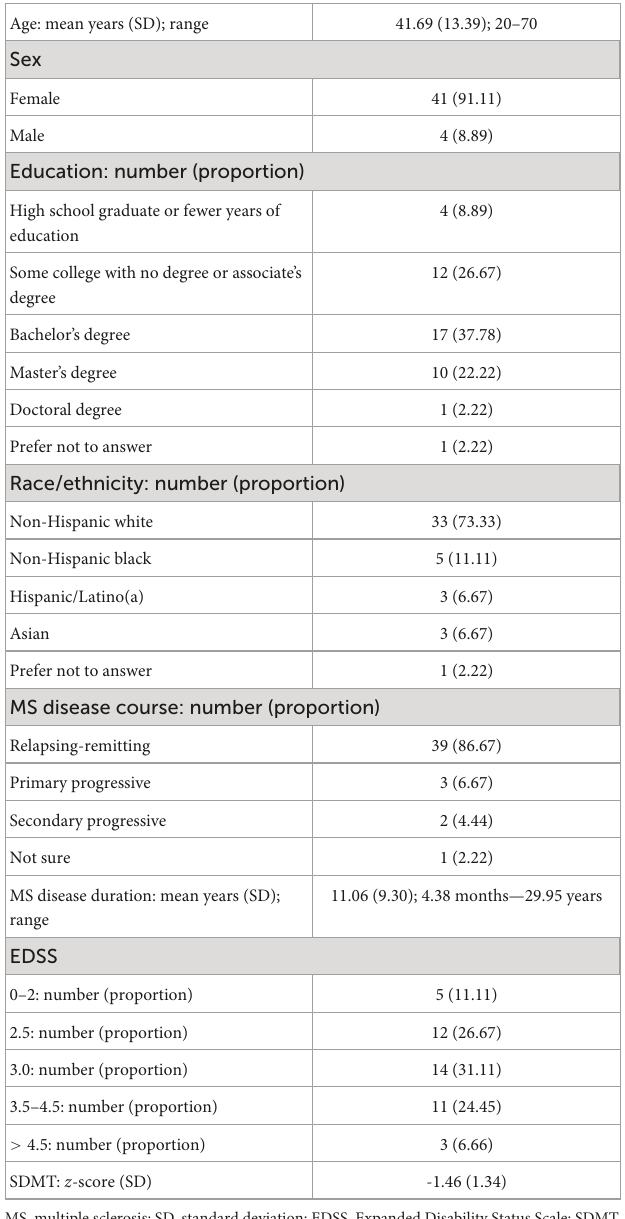
TABLE 2 Demographic and clinical characteristics of the sample. TABLE 3 Intraclass correlations (ICCs) for each symptom